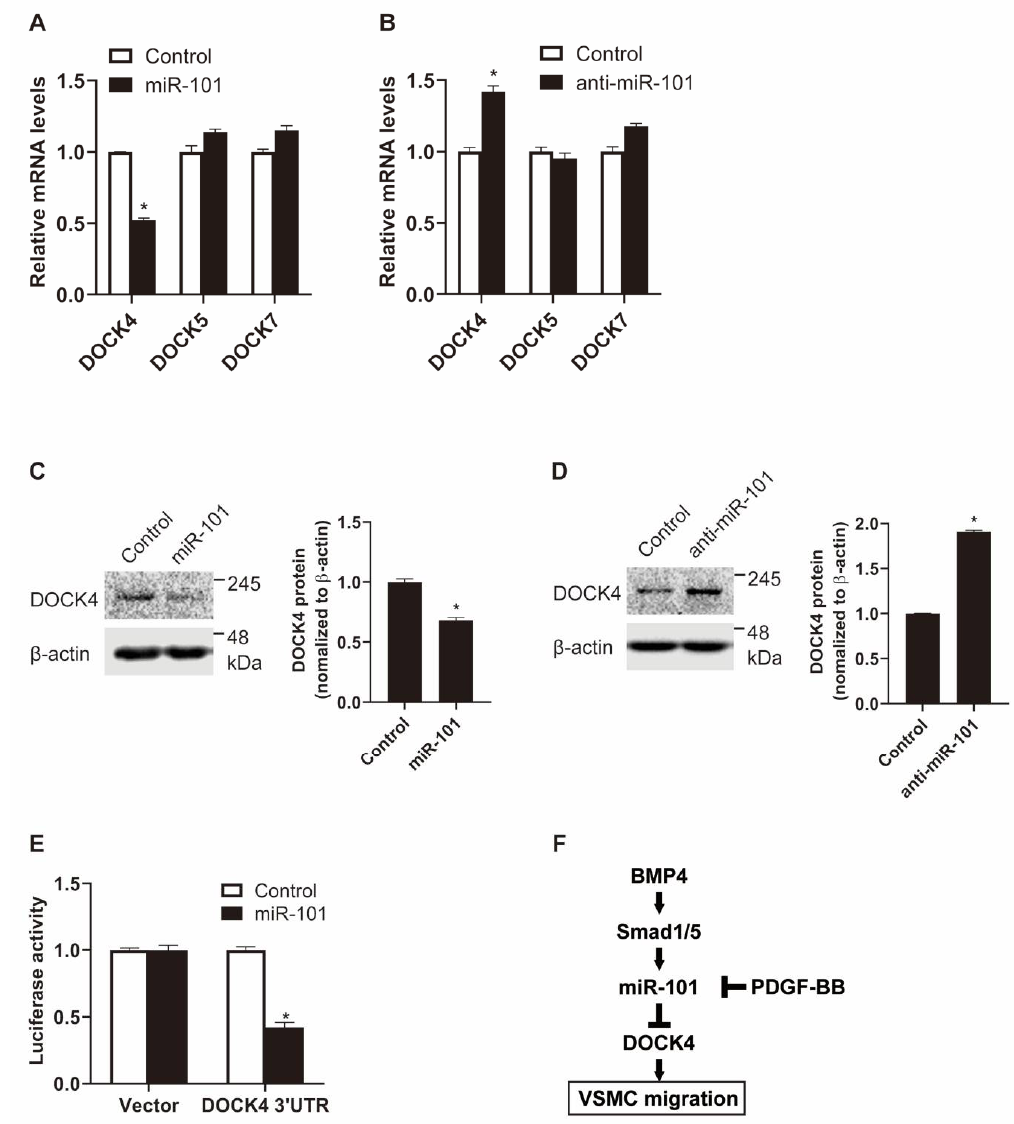
Figure 5. miR-101 targets the 3’-UTR of dedicator of cytokinesis 4 ( DOCK4 ) mRNA. ( A , B ) Levels of DOCK4 , 5 , and 7 relative to 18S rRNA in PASMCs transfected with control, miR-101 mimic ( A ), or anti-miR-101 ( B ) were measured by qRT-PCR. *, p < 0.05. ( C , D ) Total cell lysates from PASMCs transfected with control, miR-101 mimic ( C ), or anti-miR-101 ( D ) were subjected to immunoblot analysis with anti-DOCK4 or anti- β -actin antibodies. By densitometry, relative amounts of DOCK4 protein normalized to β-actin were quantitated. *, p < 0.05. ( E ) The luciferase activity of a construct containing the 3’-UTR of DOCK4 was examined in Cos7 cells by transfecting control or miR-101 mimic. A luciferase vector without 3’-UTR sequence (Vector) was used as a negative control. The data represent the mean ± S.E. of triplicates. *, p < 0.05. ( F ) Schematic diagram of the function of miR-101-mediated downregulation of DOCK4 in VSMCs.